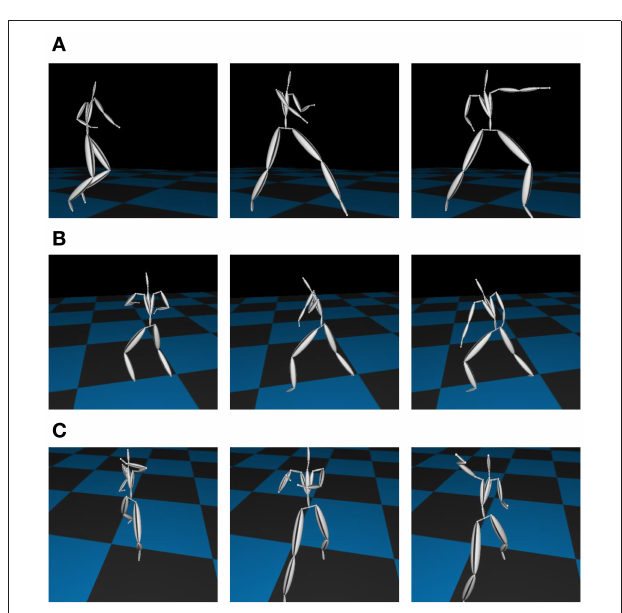
FIGURE 11 | Basic motions in Kata: (A) Left punch. (B) Left lower guard. (C) Right upper guard.